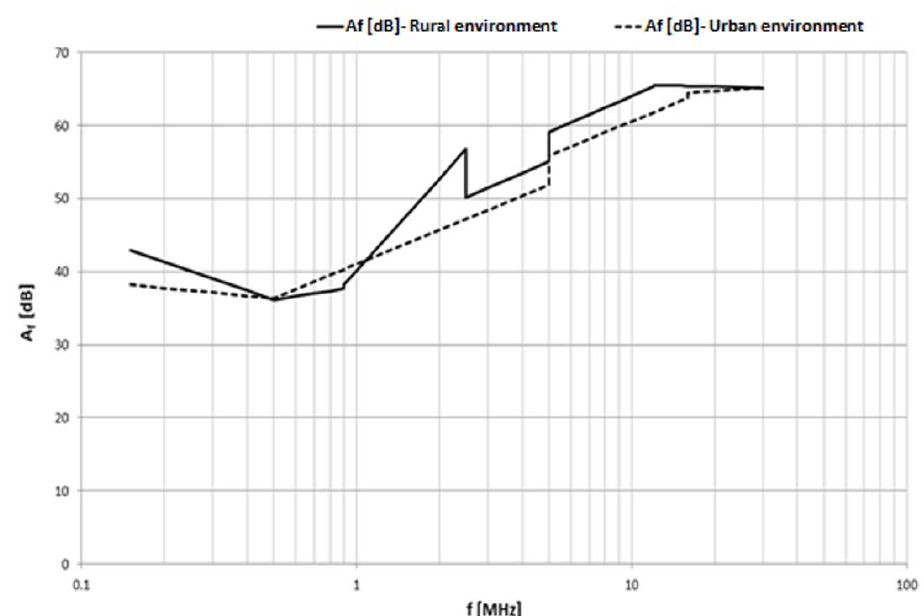
Figure 5. Required additional insertion loss T introduced by mains filters intended to protect against electromagnetic information leakage in the 150 kHz–30 MHz frequency range for all low-voltage power lines in urban and rural